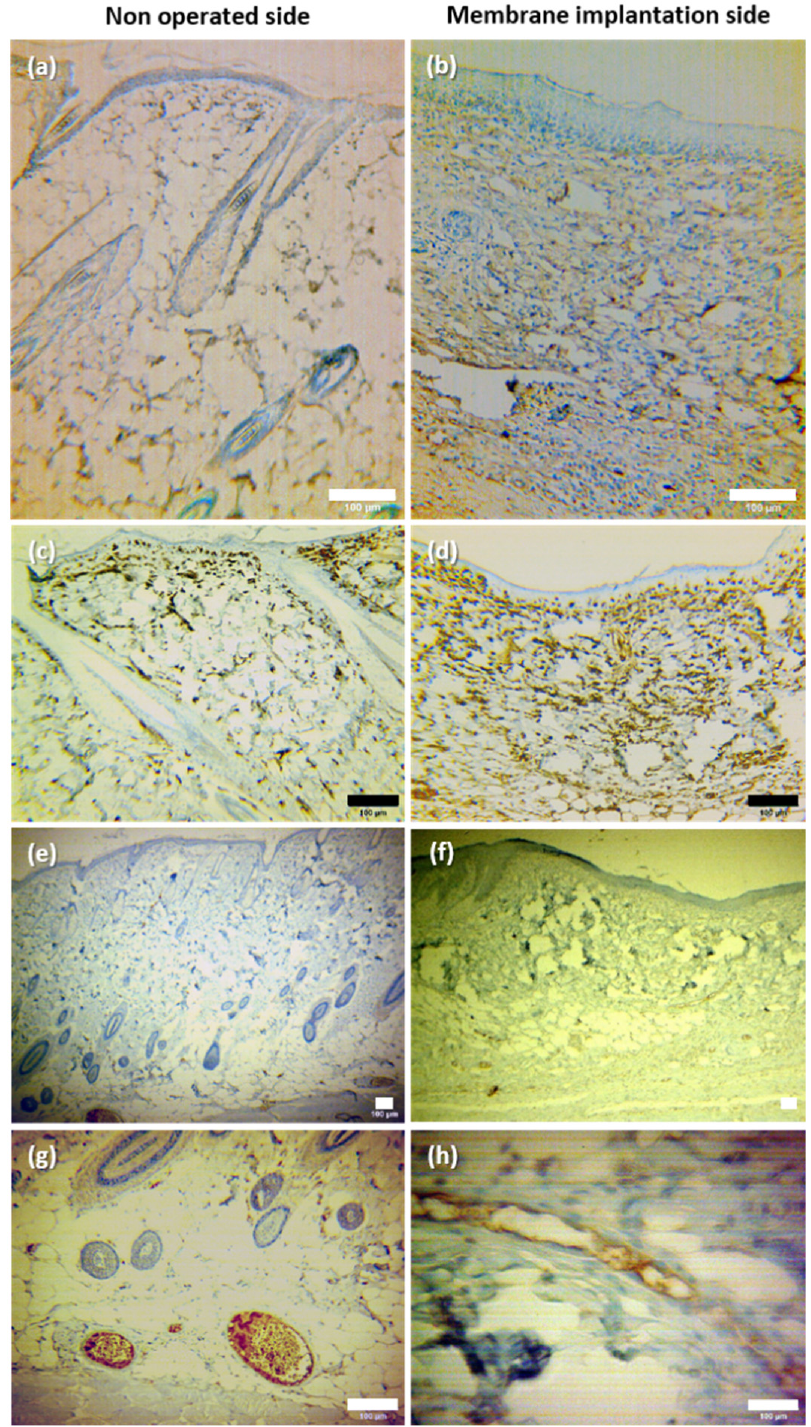
Figure 12. Typical microphotographs of the non-operated side and of the membrane implantation side of the dorsal skinfold chamber after immunohistochemistry staining for: ( a , b ) basal undifferentiated keratinocytes (using cytokeratin) 5; ( c , d ) fibroblasts (using vimentin); ( e – h ) endothelial cells (using CD-31). Scale bar = 100 μ m.